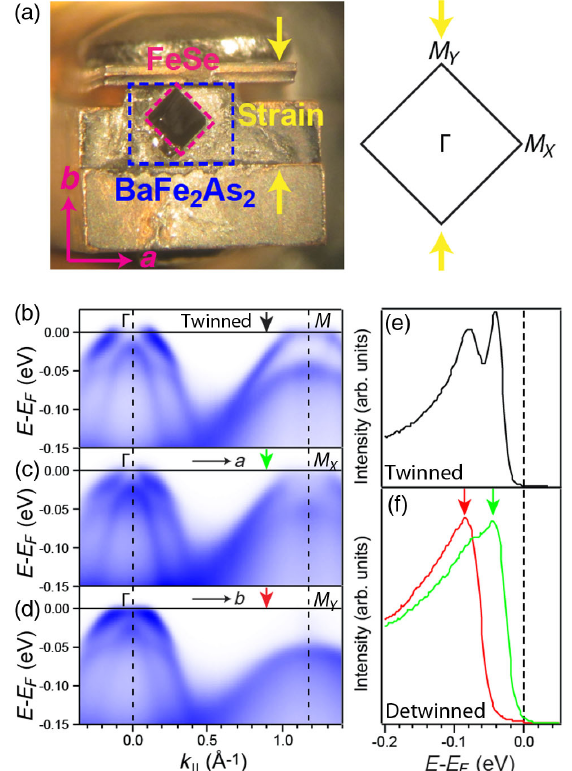
FIG. 1. Effectiveness of detwinning by uniaxial strain. (a) The mechanical uniaxial strain setup consists of a clamp that presses a single crystal of BaFe 2 As 2 , which transfers the strain to the FeSe single crystal glued on top. Both the BaFe 2 As 2 and FeSe are oriented such that the Fe ─ Fe bond is aligned to the direction of strain. When cooled below T S , the shorter (longer) Fe ─ Fe bond is along (perpendicular to) the strain direction, defining the Γ − M Y ( Γ − M X ) momentum direction. (b) ARPES spectra taken along the Γ − M direction on a twinned FeSe. (c),(d) ARPES spectra taken on detwinned FeSe along the Γ − M X and Γ − M Y directions, respectively. (e),(f) EDCs taken at the momentum pointed to by arrows in (b) – (d). All measurements are taken with 70 eV photons under odd polarization with respect to the cut